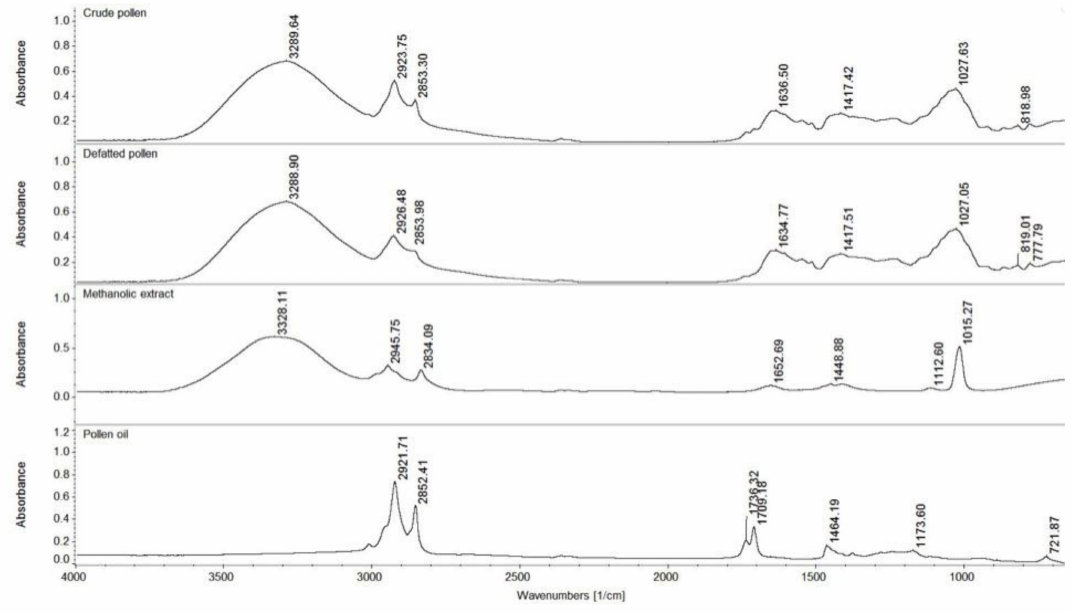
Figure 1. Fourier-transform infrared spectroscopy FT-IR spectra for bee bread, ethanolic extract and bee bread